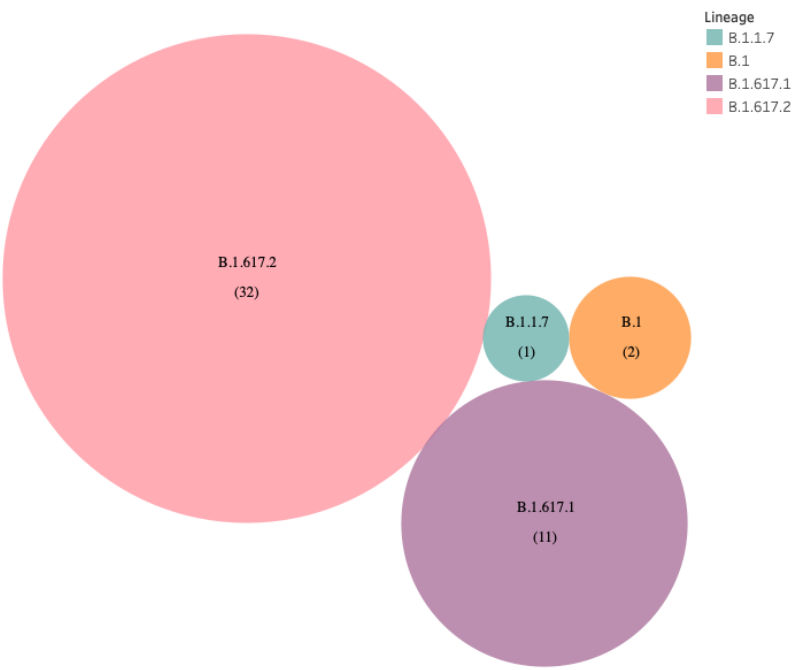
Figure 2. The phylogenetic distribution of lineages in 46 vaccinated samples.